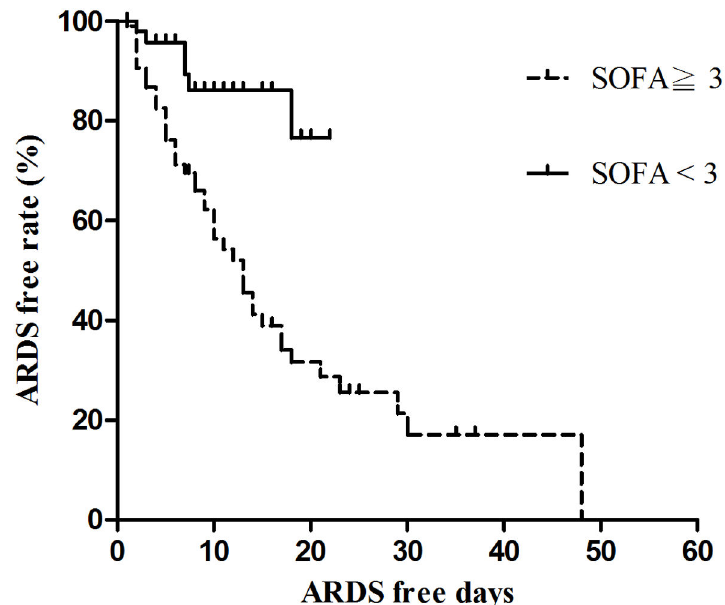
Figure 1. Cumulative ARDS free rates based on SOFA 48-h